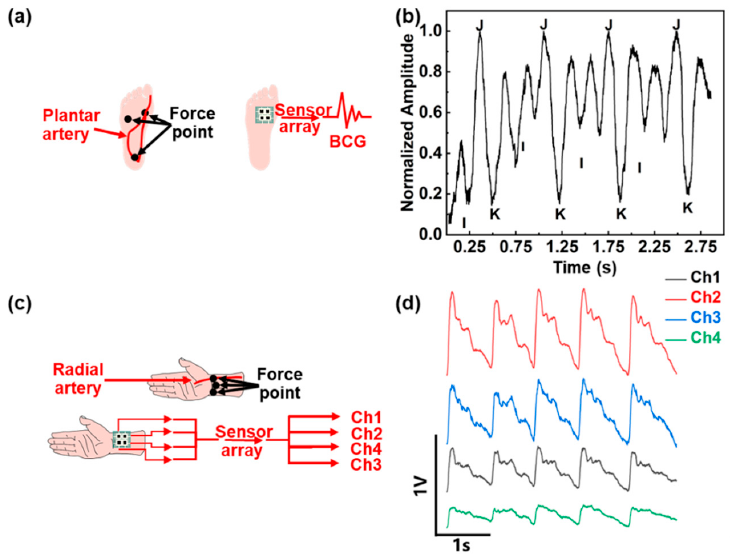
Figure 6. Monitoring of the BCG and pulse wave signals by the proposed system. ( a ) Diagram of the hardware setup to acquire BCG and ( b ) the measured waveform. ( c ) Diagram of the hardware setup to acquire four-channel pulse wave and ( d ) the measured waveforms.